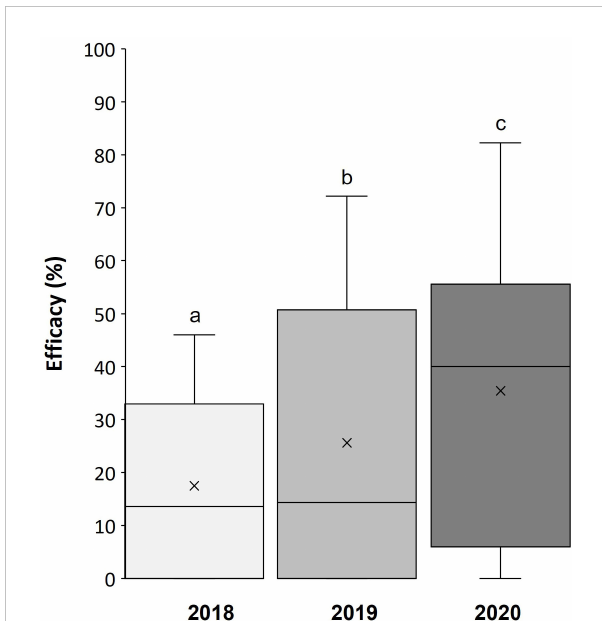
FIGURE 1 Ef fi cacy (%) of treatments with eight commercial biocontrol agents (BCAs) in reducing gray mold in ripened grapevine berries during three seasons (2018 to 2020). The box extends from the 25 th to 75 th quartile of the data distribution, the line crossing the box represents the median and × indicates the average; whiskers extend to the maximum and minimum. Ef fi cacy was calculated in relation to an untreated control for berries treated in the vineyard sampled at 1, 3, 6, 9, and 13 days after treatment (DAT), arti fi cially inoculated with a conidial suspension of Botrytis cinerea in the laboratory, and then incubated under optimal conditions for the pathogen for one week before disease severity assessment. Each box plot then represents 144 experimental data points (eight BCAs, six DAT, three replicates). Differences between years were signi fi cant at P < 0.001 and accounted for 9.1% of the total variance in disease severity. Different lowercase letters indicate signi fi cant differences according to the least-square difference test at P <